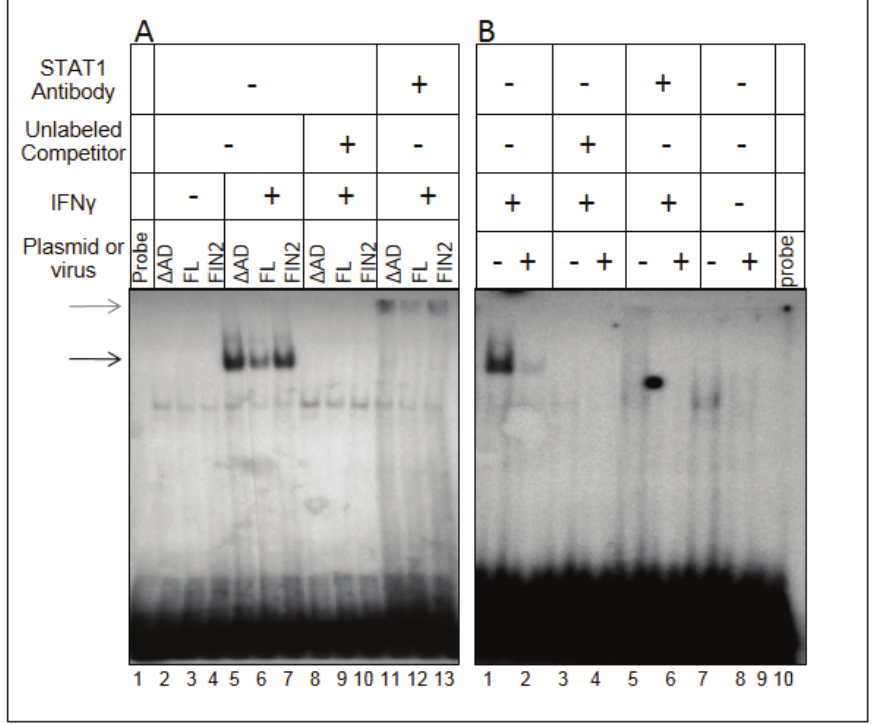
Figure 6. Reduced binding of STAT1 to GAS elements in the presence of IE1. Film image of an Electrophoretic Mobility Shift Assay shows a reduction in the amount of IRF1 GAS element probe that is shifted upon mixture with nuclear extracts from MRC5 cells ectopically expressing IE1 ( A ) and HCMV infected cells ( B ). In A, MRC5 cells were nucleofected with plasmid harboring full length IE1 (FL), the Δ 345–491 C-terminal truncation IE1 ( Δ AD) or empty vector (FIN2). At 24 hours after nucleofection, cells were exposed to 100 U/mL of IFN γ or left untreated. At 30 minutes after treatment, cells were solubilized and nuclear extracts were isolated as described in Materials and Methods. Nuclear extracts were mixed with the GAS element of the IRF1 gene with or without addition of unlabeled probe and with or without anti-STAT1 antibody. Resulting complexes were resolved by electrophoresis on a 4.5% native polyacrylamide gel. In a second experiment ( B ), MRC5 cells were exposed to 1 PFU per cell of the AD169 strain of HCMV or left uninfected. At 12 hours after infection, cells were solubilized and processed as described above. The black arrow indicates the shifted bands and the grey arrow indicates the supershifted